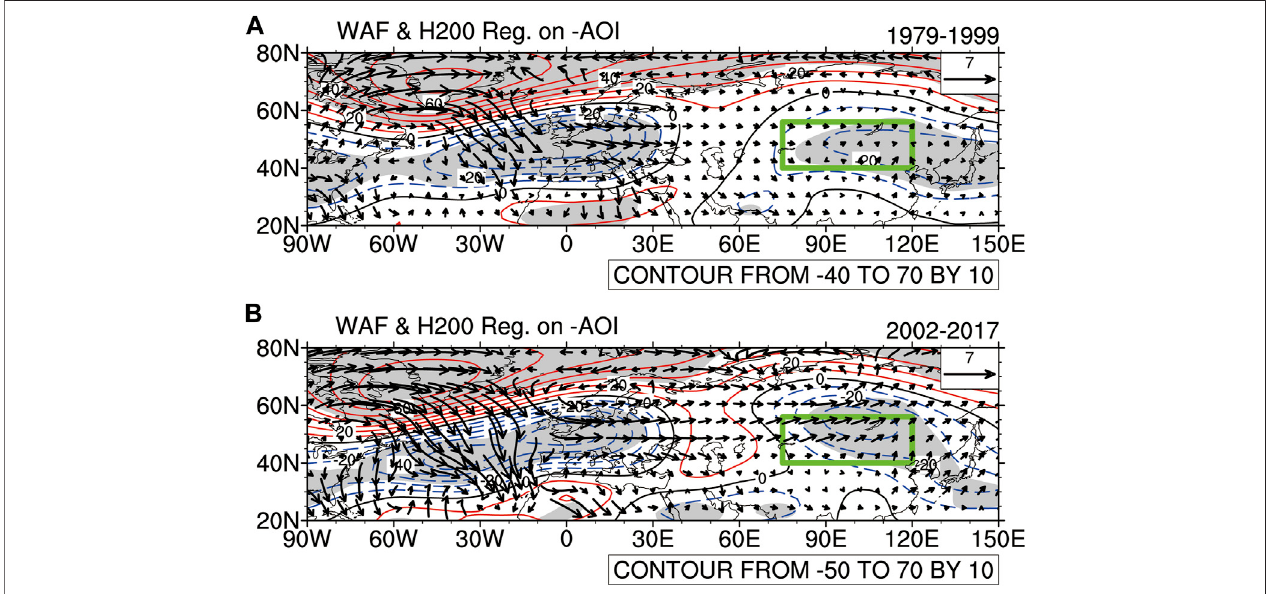
FIGURE4|(A,B) RegressionmapsoftheRossbywaveactivity fl uxes(vectors;units:m 2 s − 2 )andgeopotentialheight(contours;units:gpm)at200 hPaupon − AOI during (A) 1979 – 1999 and (B) 2002 – 2017. The green frame denotes the location of the study area (40 ° – 56 ° N, 75 ° – 120 ° E). The shaded areas indicate statistical signi fi cance at the 95% con fi dence level based on the Student ’ s t -test.